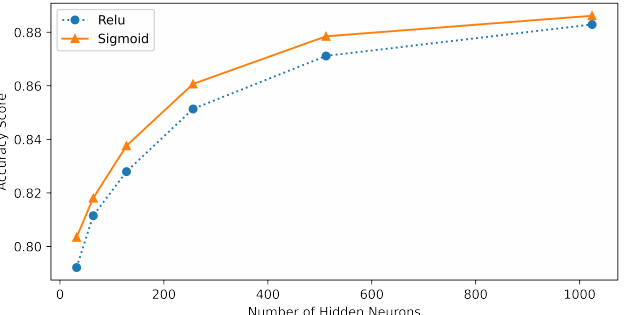
Figure 12. Performance comparison of ELM with different numbers of hidden nodes and activa- tion